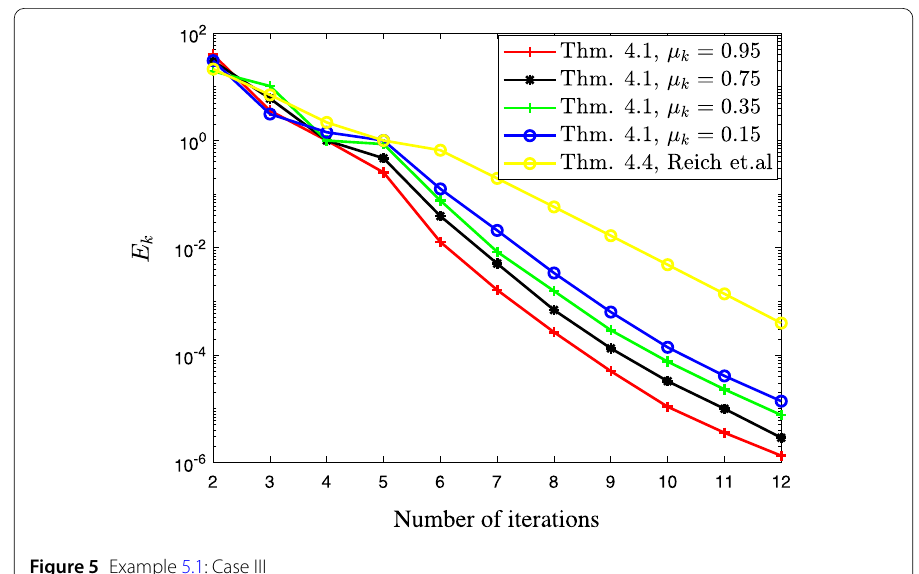
Figure 5 Example 5.1: Case